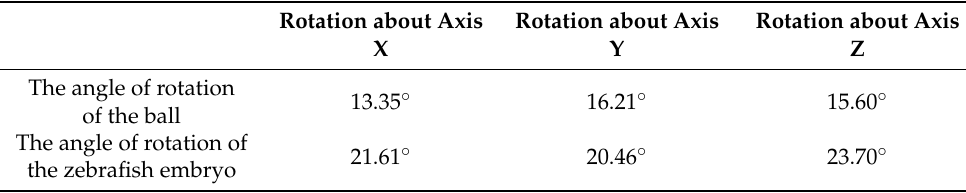
Table 2. Rotation angle of the micro-object in